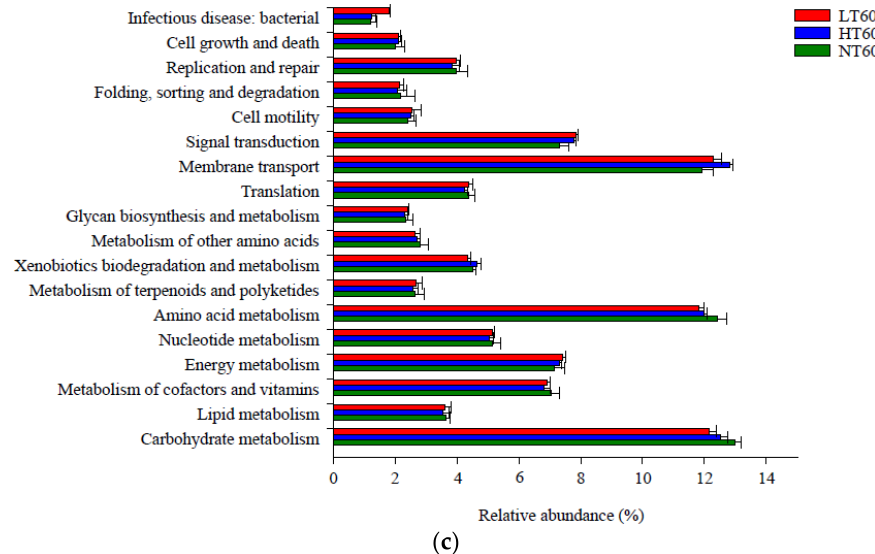
Figure 6. Level 2 functional metabolic pathways with a relative abundance greater than 1% in soil bacterial community at 0–20 ( a ), 20–40 ( b ), and 40–60 ( c ) cm depths.